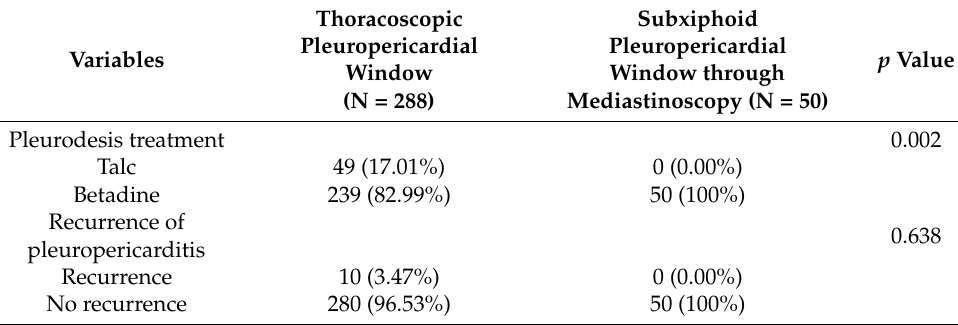
Table 3. Pleurodesis treatment and recurrence rates by surgery approach.